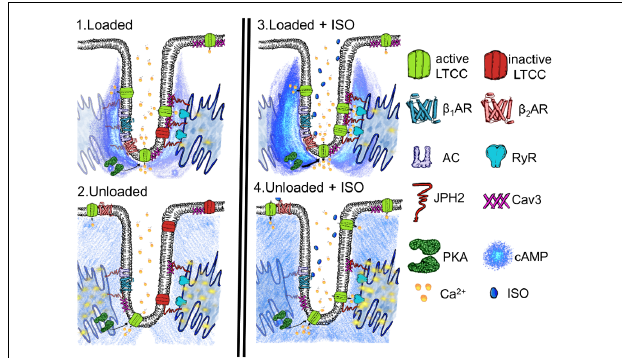
FIGURE 6 | Schematic demonstrating the speculated state of a t-tubular microdomain in loaded or unloaded scenarios with or without isoprenaline stimulation. (1) Loaded cell. LTCC are generally active within the tubule owning to some constitutive cAMP production and consequent PKA activity, scaffolded by Cav-3 and JPH-2. Calcium spark activity at the sarcoplasmic reticulum is nominal. (2) Unloaded cell. LTCC are generally inactive as there is a loss of coherent confinement of cAMP and PKA activity to the t-tubular microdomain. This is due to the mechanosensitivity of the association between Cav1.2, Cav-3, and JPH-2 and the loss of t-tubules. Even though there is a smaller amount of LTCC activity spark activity increases as orphaned RyR no longer receive effective control and thus experience a gain of function. (3) Loaded cell stimulated with ISO. After stimulation β 2AR increase cAMP levels in the cytoplasm of the sarcomeric dyad and this activates a sub-population of PKA which activates almost all LTCC. Spark activity remains nominal as effective measures to control LTCC and RYR phosphorylation and the degradation of cAMP remain effective due to scaffolding by the cellular microdomain. (4) Unloaded cell stimulated with ISO. Despite a reduction in the amount of cAMP response initiated by β 2 AR in the cytosol, signals still reach RII_PKA domains, due to the loss of efficient cAMP compartmentation. This stimulates further aberrant spark activity due to the relatively uncontrolled calcium influx in the cell and EC mediator hyperphosphorylation following the loss of normal structure within the sarcomeric dyad following